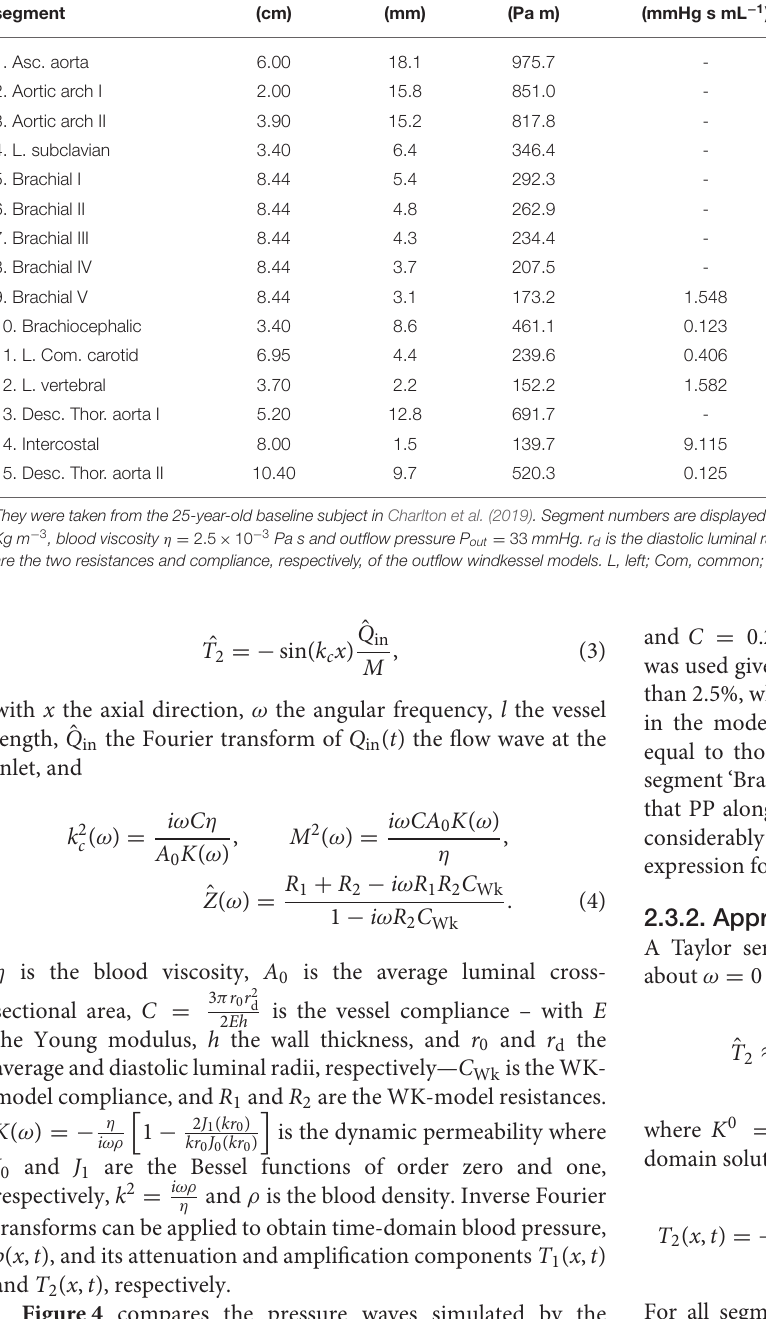
TABLE 2 | Vascular parameters of the reduced model. Arterial Length r d Eh R 1 R 2 C Wk segment